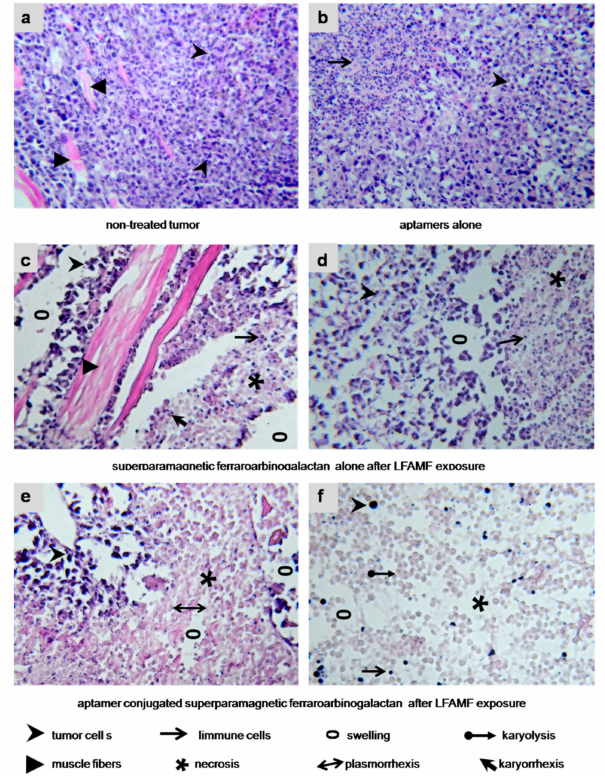
Figure 8. Histological features of the treated tumors. ( a ) Non-treated Ehrlich carcinoma. The invasive tumor has a solid structure composed of atypical cells with pleomorphic, hyperchromatic nuclei of di ff erent shapes and volume and grows into the muscle tissue. No immune response. ( b ) Treated with an aptamer mix. Carcinoma cells are with cytoplasm vacuolization; lymphocytic infiltration is moderate. ( c , d ) FrFeAG and LFAMF treated carcinoma has scattered tumor necrosis among the remaining carcinoma tissue with inflammatory infiltration around them. ( e , f ) AS-FrFeAG in LFAMF caused irreversible damaging e ff ects on the treated tumor, such as karyo and plasmolysis, and karyo and plasmorrhexis. Large tumor necrosis area, on the periphery of which remains small amounts of dead carcinoma cells with destructive changes of the cancer tissue microenvironment. Visible inflammatory infiltration of segmented leukocytes and swellings observed. Magnification ×